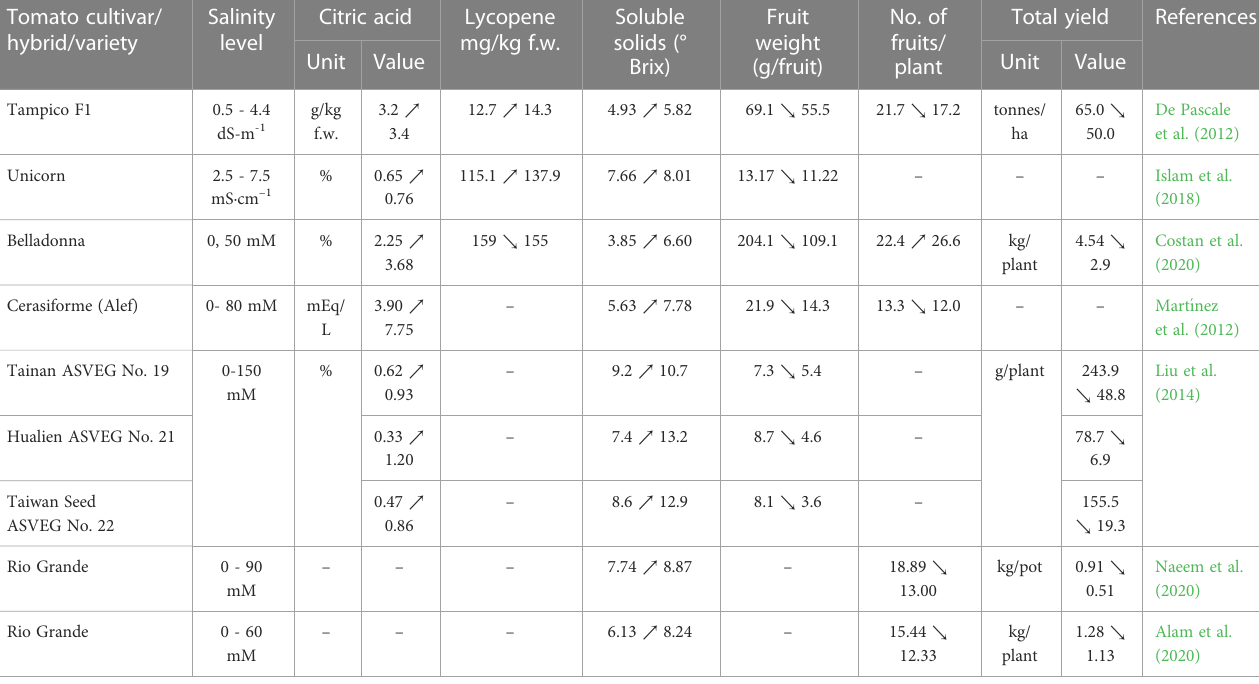
TABLE 6 Salinity impact on yield and citric acid, lycopene, soluble solids contents in tomato fruits. Tomato